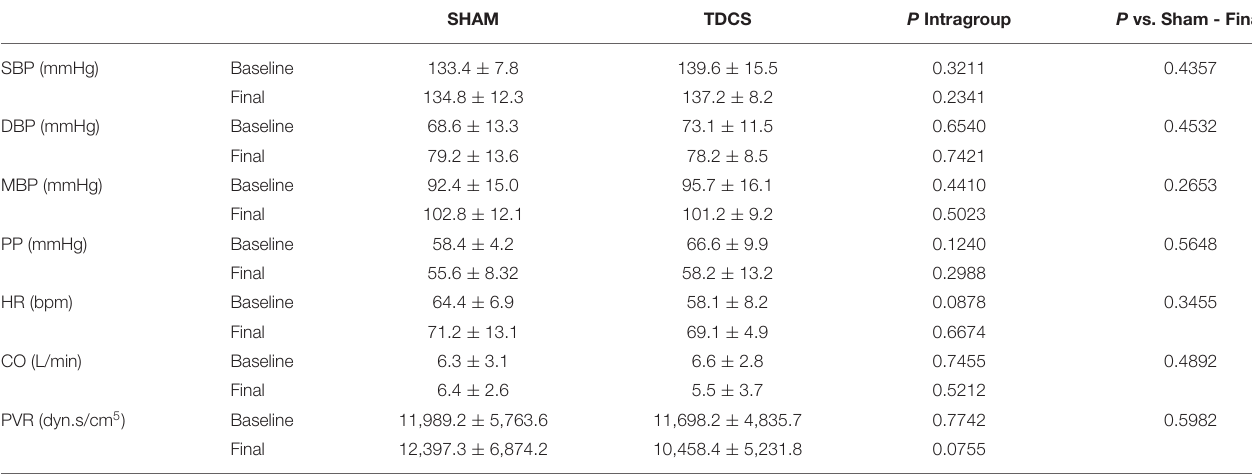
TABLE 4 | Short-term intervention (10 sessions): hemodynamic variables at baseline and final of the tDCS or SHAM conditions. SHAM TDCS P Intragroup P vs. Sham -